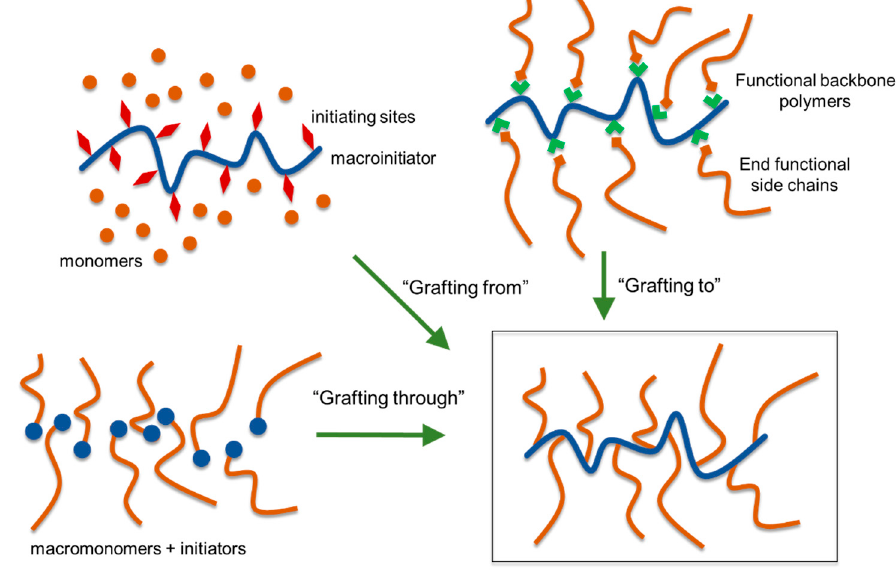
Figure 17. Polymer grafting strategies.